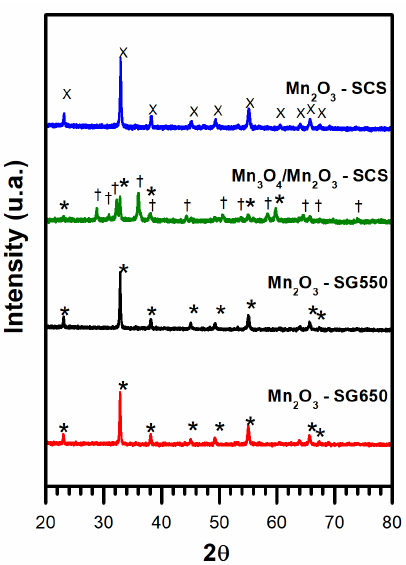
Figure 1. X-ray powder diffraction patterns of the synthesized catalysts. Assignments: Mn 2 O 3 peaks = X and *; Mn 3 O 4 = †.